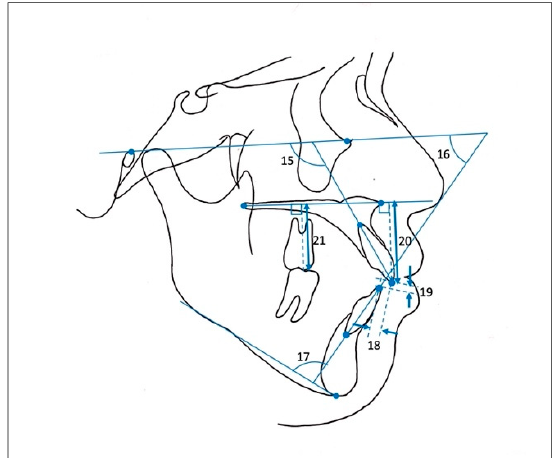
Figure 5. Cephalometric measurements (denture pattern). 15: U1 to FH plane angle (U1 to FH); 16: Frankfort mandibular incisor angle (FMIA); 17: incisor mandibular plane angle (IMPA); 18: overjet; 19: overbite; 20: upper incisor height; 21: upper molar height.